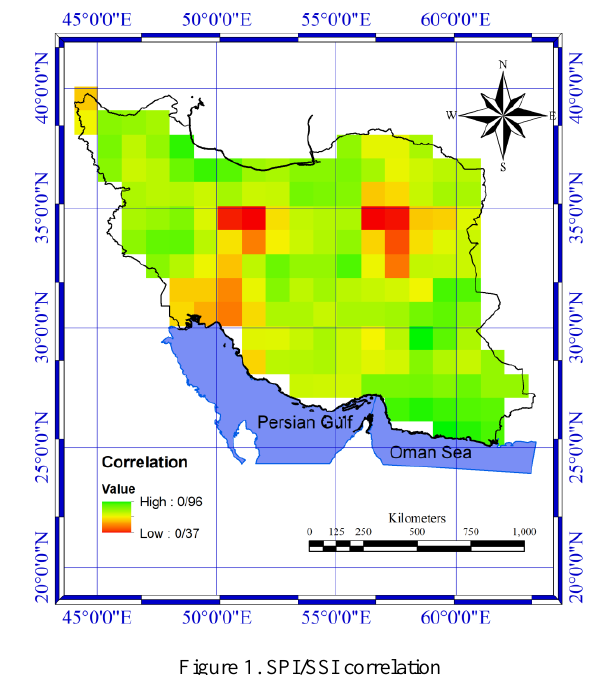
Figure 1. SPI/SSI